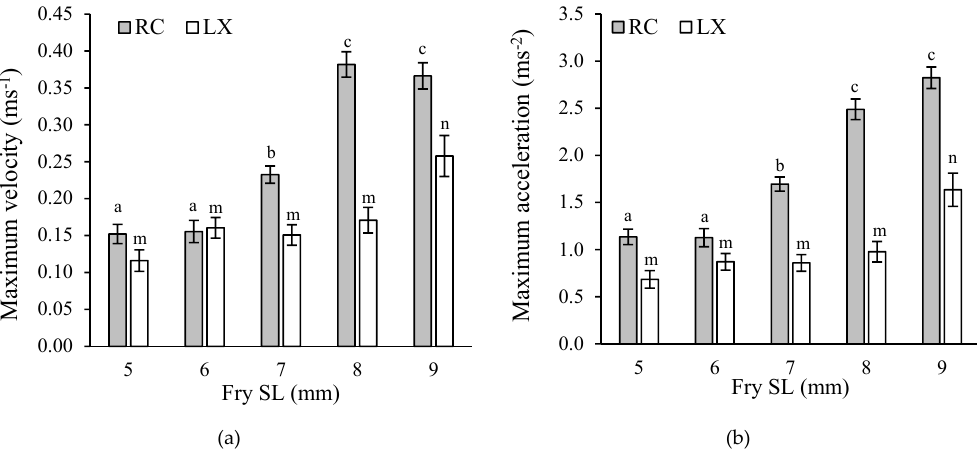
Figure 10. ( a ) Maximum velocity (m·s − 1 ) and ( b ) acceleration (m·s − 2 ) for cichlid fry of lengths 5 to 9 mm SL, from parents from Río Cabuyo (RC) in Costa Rica and from Laguna de Xiloá (LX) in Nicaragua. Letters above bars indicate post-hoc pairwise comparison tests across fry sizes within each site. Data from [17,21].